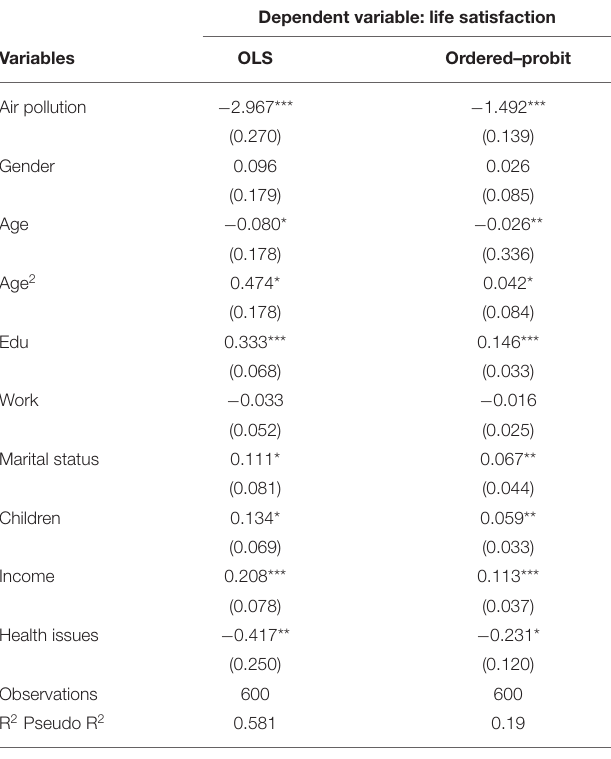
TABLE 1 | The effect of air pollution on subjective life